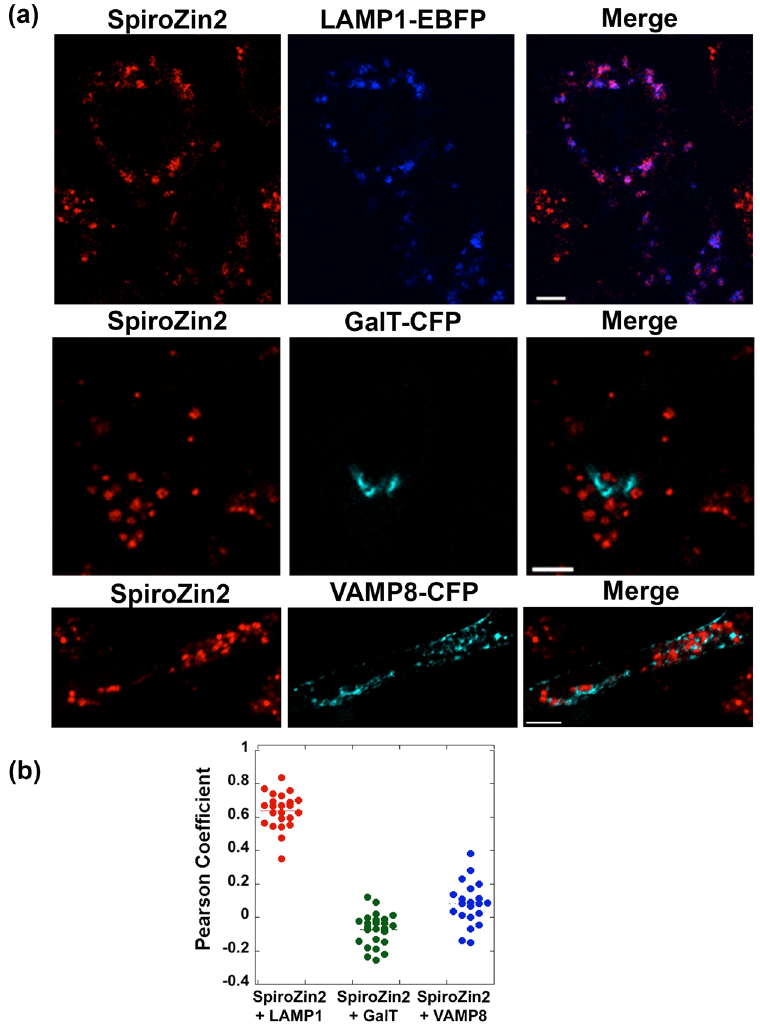
Figure 3. Co-localization analysis of SpiroZin2 and three vesicular markers demonstrates that SpiroZin2 resides in lysosomal vesicles. ( a ) Representative images of SpiroZin2-stained cells, vesicular markers- FP, and merged channel. ( b ) Pearson coefficient plot of co-localization analysis. Pearson analysis included a minimum of 21 cells per condition. Scale bar, 5 μ